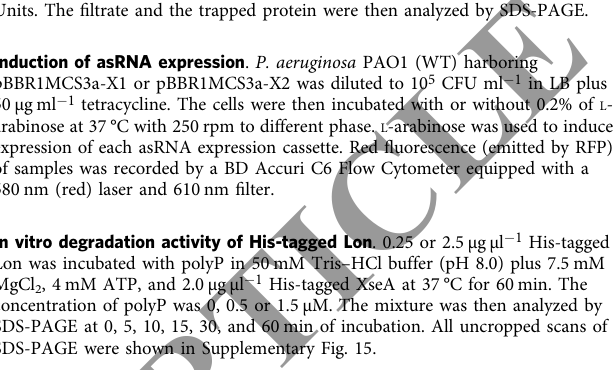
Table 5. Poly(dC) derivatives included exonuclease I-partially digested poly(dC 12 ), DNase I-partially digested poly(dC 12 ), and poly(dC 12 )*. P-poly(dC) derivative included P-poly(dC 12 )*. Poly(dC 12 ) and P-poly(dC 6,12,30 ) were used to form the mixture. The molar ratios of poly(dC 12 ) and each P-poly(dC) were 1:1, 1:10 − 1 , 1:10 − 2 , 1:10 − 3 , and 1:10 − 4 , respectively. Poly(dC 12 ) and P-poly(dC 12 )* were used to form the mixture at the molar ratio of 1:1. Other ssDNAs included ATG TGC